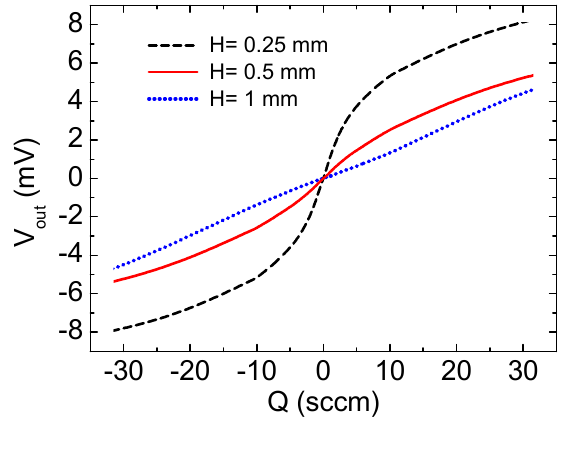
Figure 11. Responses of double heater structures to a nitrogen flow. The structures were packaged with different channel heights, H , indicated in the figure for each